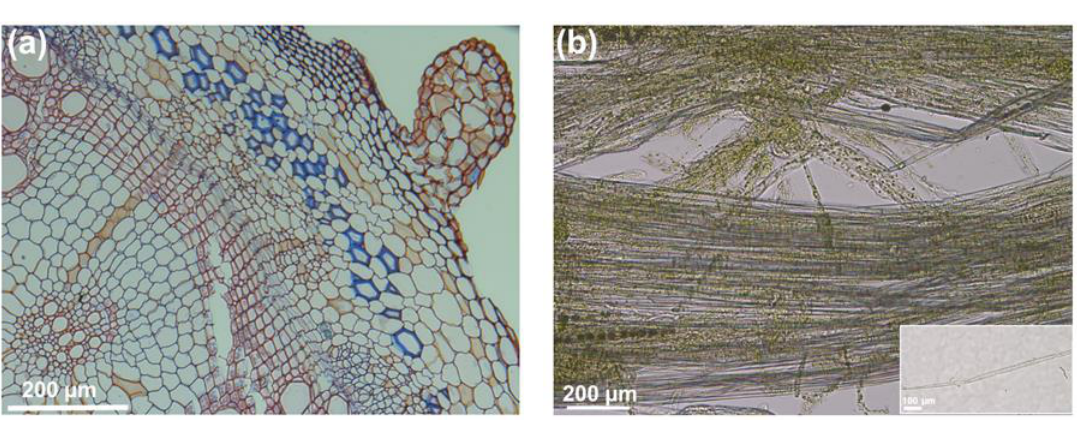
Figure 1. Cross section of the stem of a representative fiber crop, stinging nettle ( Urtica dioica L.), and details of enzyme-treated cortical peels with some separated bast fibers. ( a ) Transversal cross section stained with Safranin and Alcian blue (FASGA staining), showing in blue the cellulosic bast fibers and in red lignin; ( b ) cortical peels separated from the stem bottom internodes and treated for 24 h at 50 °C with TEXAZYM BFE (INOTEX Ltd, Czech Republic) showing some separated bast fibers; the inset shows one separated bast fiber.